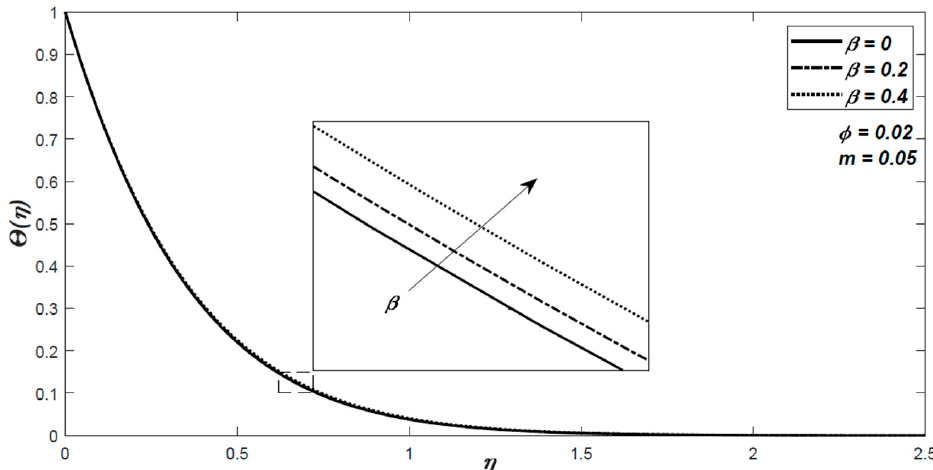
Figure 5. The variation of the nondimensional temperature for different values of the ferromagnetic parameter β .